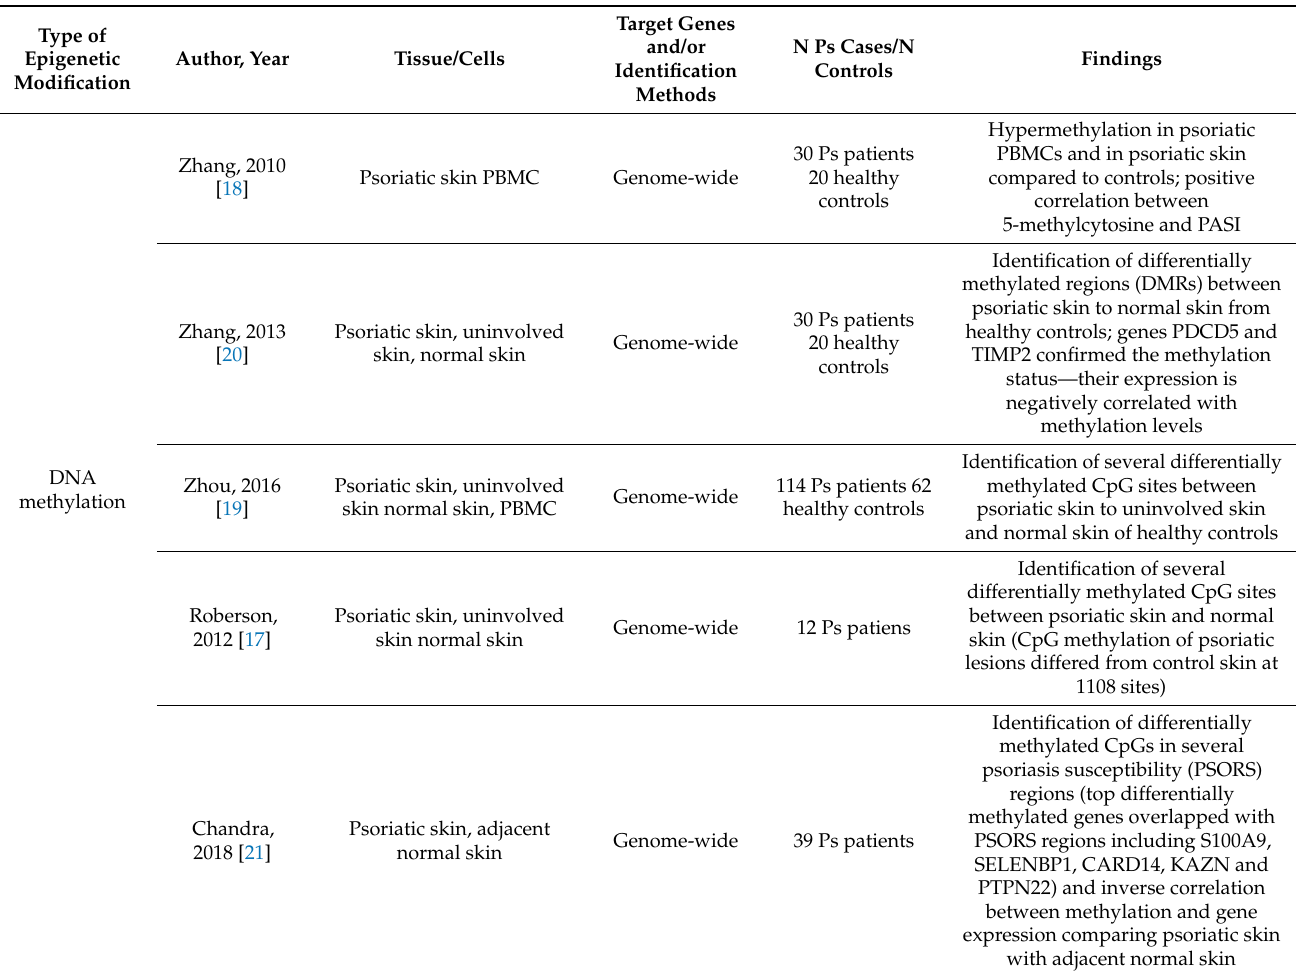
Table 1. Studies of epigenetic mechanisms in